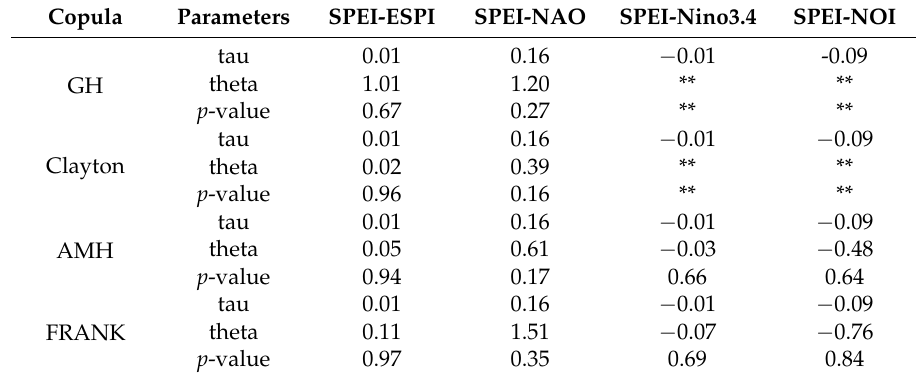
Table 2. The results of the goodness-of-fit values of four Copula functions for ESPI, NAO, Nino3.4 and NOI. **means that no such value exists because the rank correlation is